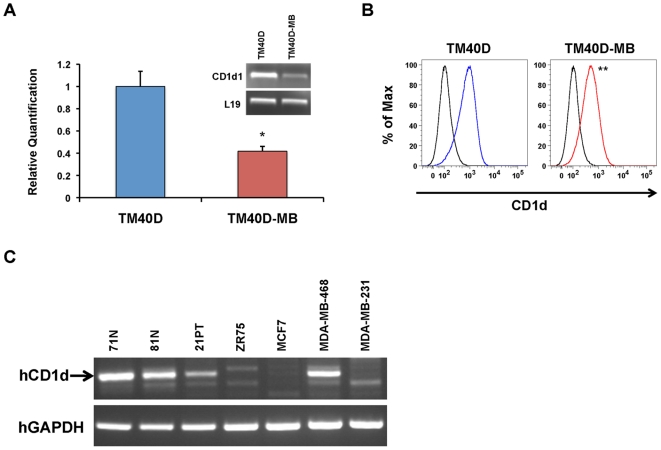
Decreased expression of CD1d in highly metastatic murine and human breast cancer cells.(A) Real-time RT-PCR assay confirming significant downregulation of the CD1d1 gene in TM40D-MB cells, as compared to parental TM40D (low metastatic) cells. L19 serves as an internal control. Experiments were performed in triplicate, and data are represented as the mean ± SEM, * P≤0.05. (B) Flow cytometry analysis of CD1d using a PE-conjugated anti-CD1d mAb (1B1) or isotype IgG2b control. Average ± SD mean fluorescence intensity (MFI) for three independent experiments: TM40D (blue)  = 928.7±21.2, TM40D-MB (red)  = 541.0±57, ** P≤0.001. (C) Decreased expression of CD1d in human mammary epithelial cells correlates with increasing metastatic potential by RT-PCR. 71N, 81N: normal transformed human mammary epithelial cells. 21PT, ZR75: primary breast adenocarcinoma cells. MCF-7: minimally invasive adenocarcinoma cells. MDA-MB-468, MDA-MB-231: highly metastatic human breast adenocarcinoma cells, from patients of African-American (MDA-MB-468) and Caucasian (MDA-MB-231) descent. GAPDH serves as an internal housekeeping gene control.